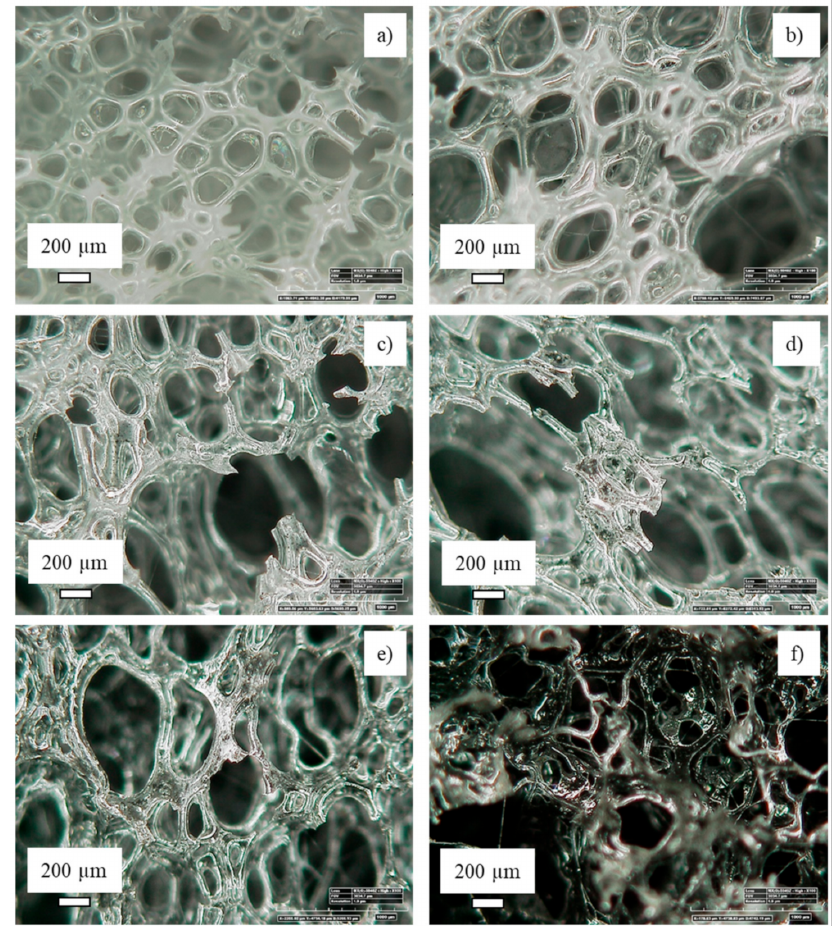
Figure 3. OM images of PUCNF0 ( a ), PUCNF0.5 ( b ), PUCNF1 ( c ), PUCNF3 ( d ), PUCNF5 ( e ), and PUCNF15 ( f